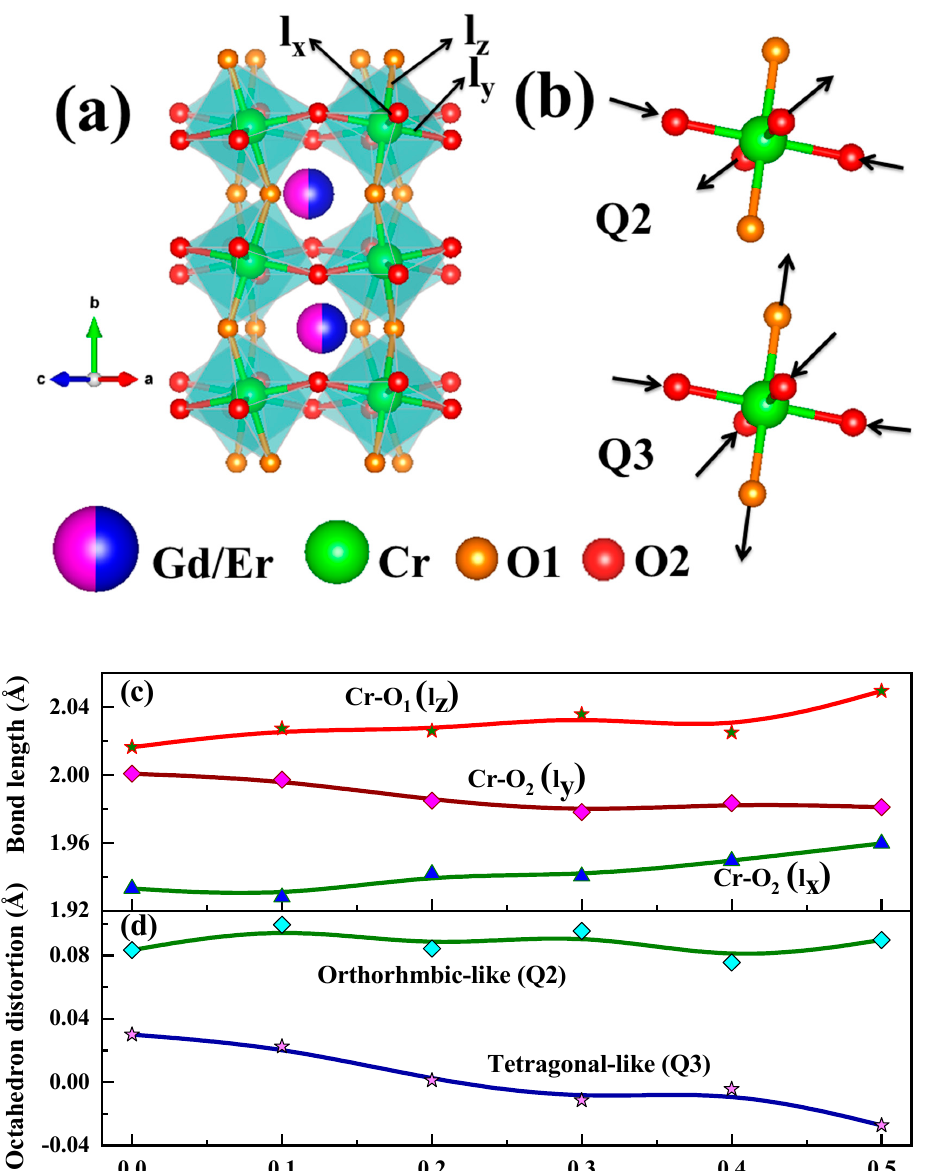
Figure 3. ( a ) Crystal structure of Gd 0.5 Er 0.5 CrO 3 compound obtained from the VESTA software; l x , l y and l z denote the long and short Cr– O 2 bond lengths mainly in the ac plane and the middle length Cr– O 1 mainly along the b axis (out of plane), respectively. ( b ) Q 2 and Q 3 represent the orthogonal-like and tetragonal-like distortions, respectively. ( c ) Bond lengths and ( d ) octahedral distortion variation as a function of Mn